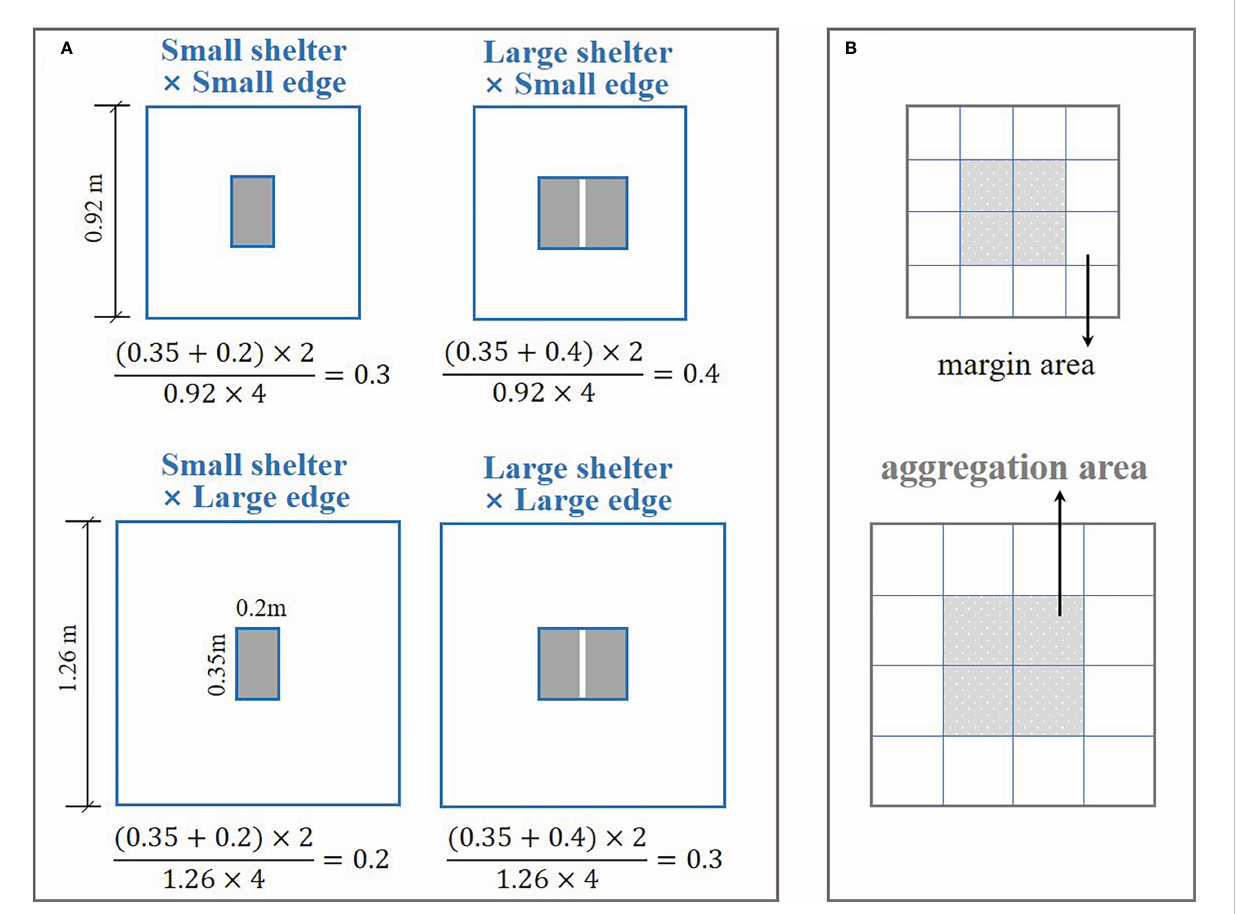
FIGURE 2 Schematic of the reef unit platform showing the size of the structural attributes. (A) Four treatments of reef unit structure: small shelter × small edge (medium ratio = 0.3), large shelter × small edge (high ratio = 0.4), small shelter × large edge (low ratio = 0.2), large shelter × large edge (medium ratio = 0.3). The equations show the calculation process for the size ratio of the shelter to edge. (B) Bottom partition of the reef unit (i.e., 4 × 4 grid). Gray squares represent the aggregation area around the central shelter, and blank squares represent the margin